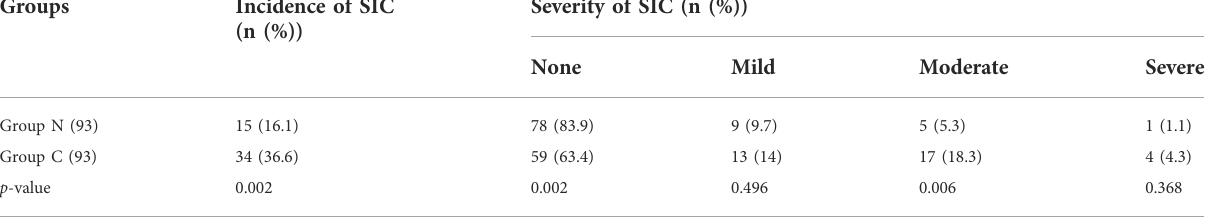
TABLE 5 Incidence and severity of cough between the two groups. Groups